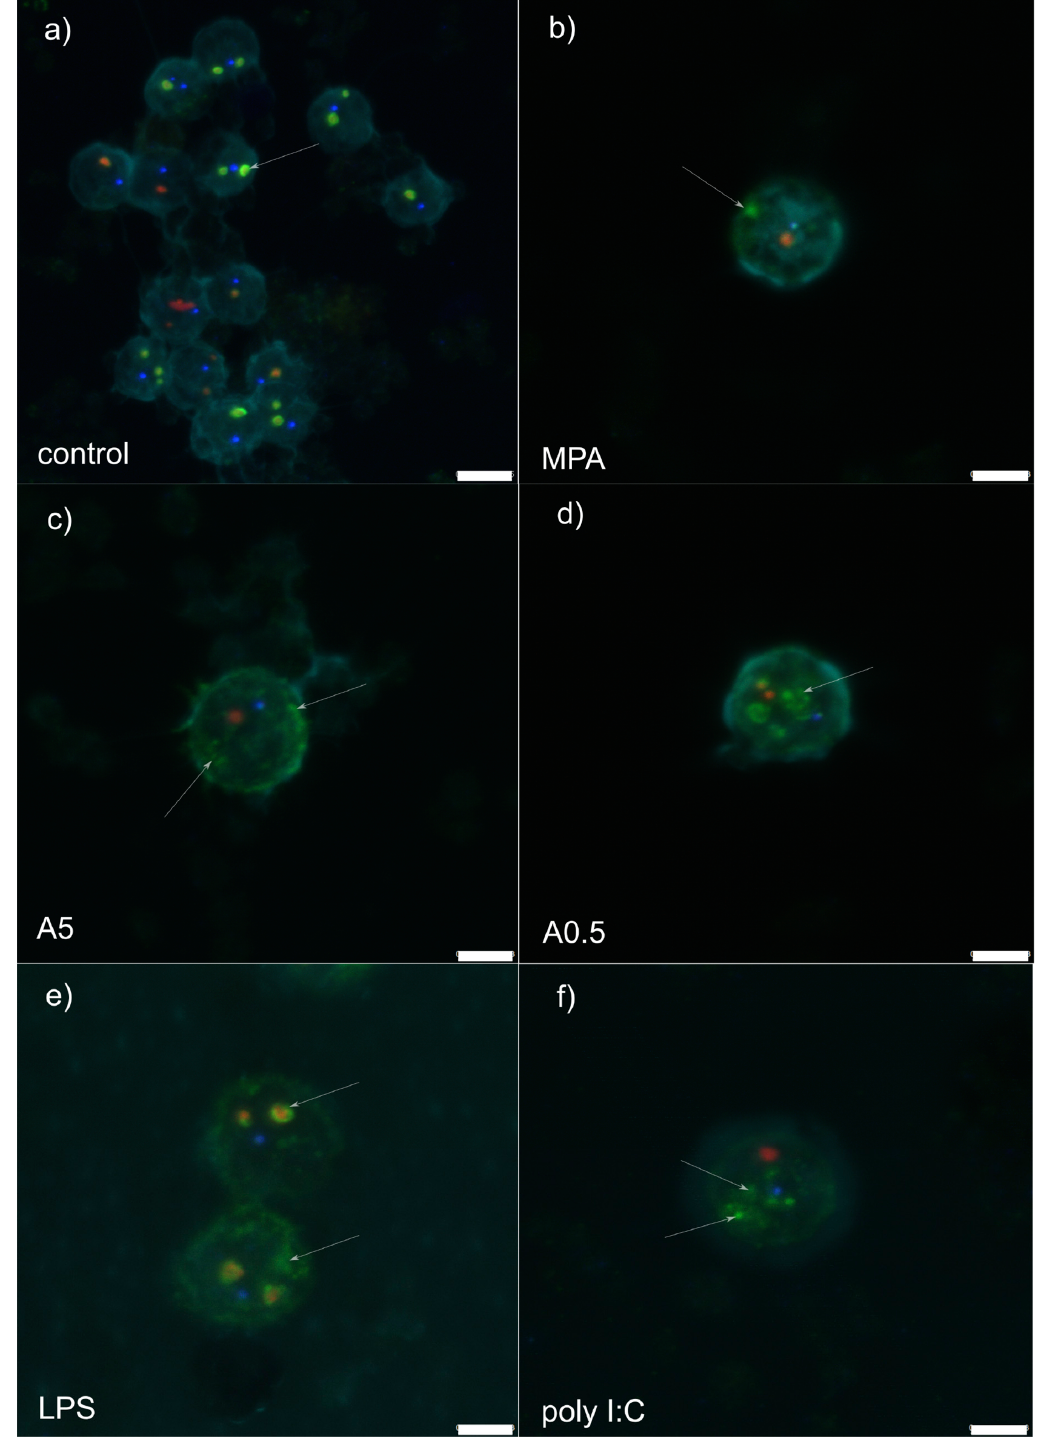
Figure 1. Z-stack representative microphotograph of immunocytochemical localization of Cajal bodies (coilin, in blue), granular components (B23 / NPM1, in green), dense fibrillar components (Nop58; in red) and cell nucleus (pale blue, labelled by 4,6-diamidino-2-phenylindole [DAPI]) in rat peripheral blood mononuclear cells 12 h post-stimulation with: ( a ) RPMI-1640 medium (control); ( b ) mycophenolic acid (MPA; immunosuppressor); ( c ) 5 µ g of A. pegre ffi i crude extract; ( d ) 0.5 µ g of A. pegre ffi i crude extract; ( e ) bacterial lipopolysaccharide (LPS); ( f ) polyinosinic:polycytidylic acid (poly I:C; viral analogue). White arrows point to the appearance of the granular components. Scale bars: 5 µ m ( a ), 3 µ m ( b – f